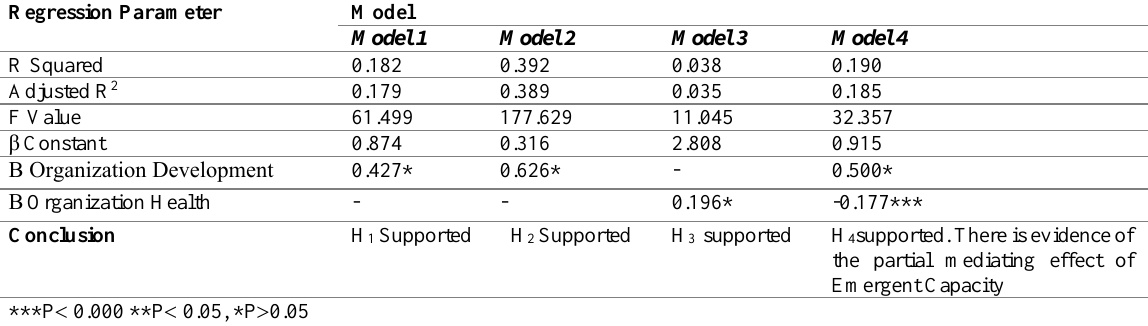
Table 5: Test of